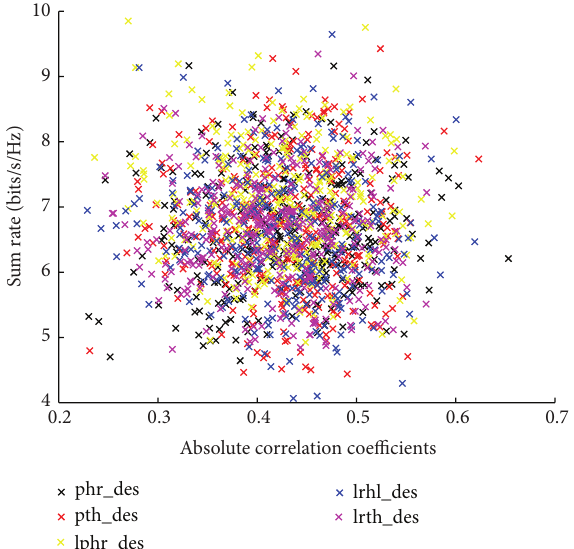
Figure 11: Scatter plot: capacity versus correlation for desired links at low band.